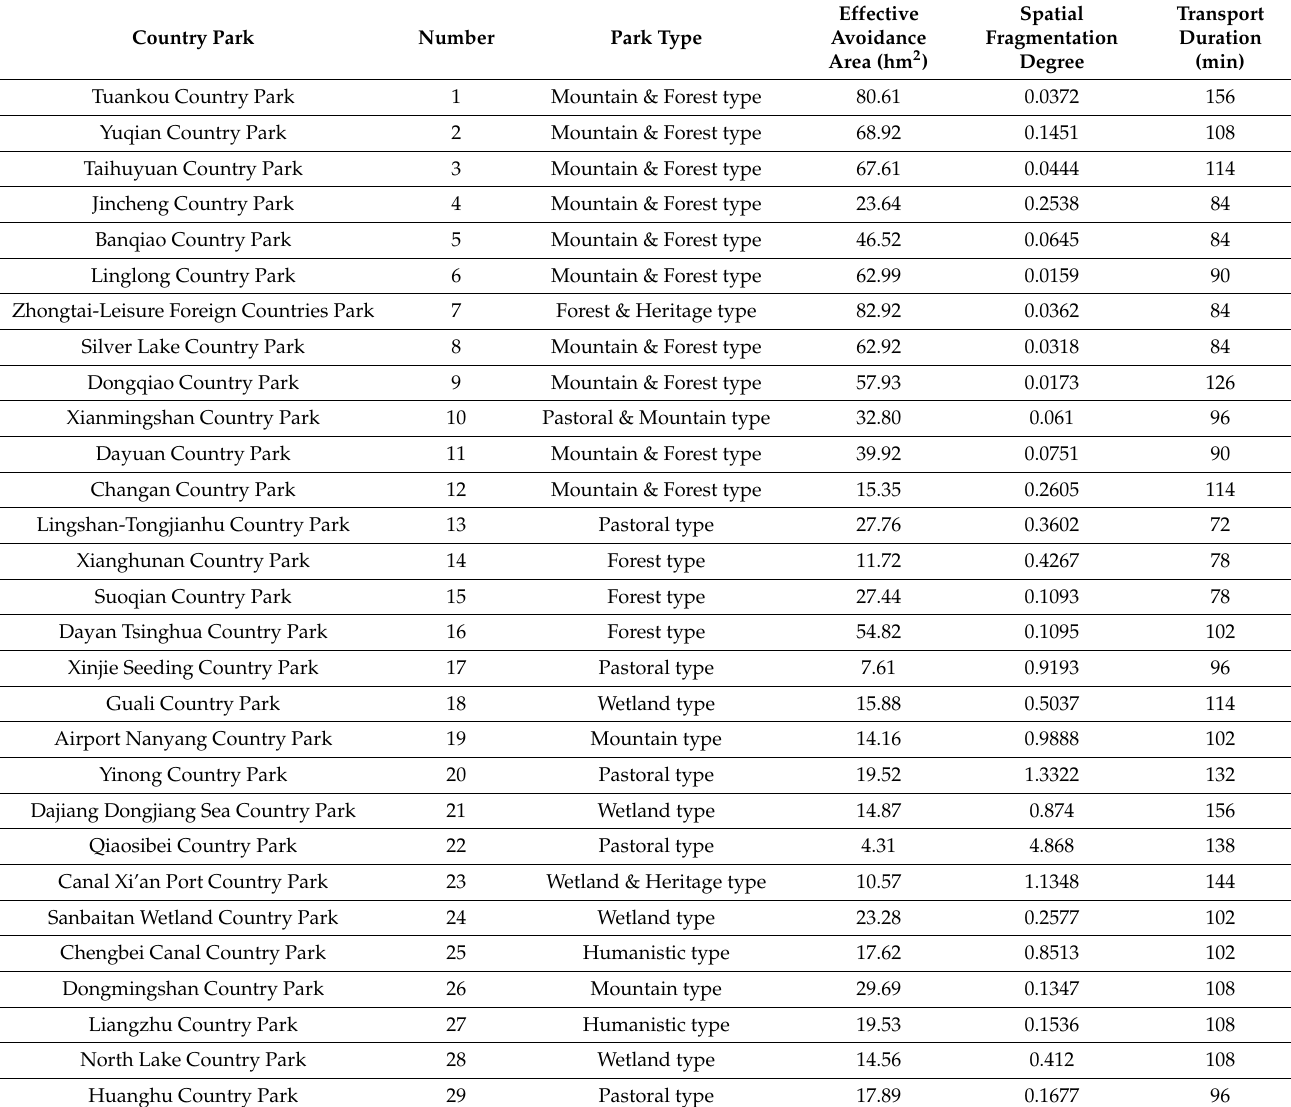
Table 1. Statistics of country parks in Hangzhou